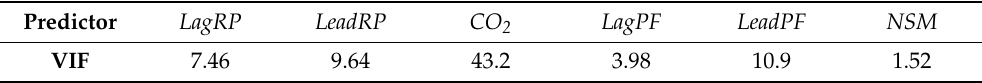
Table 4. Variance inflation factors of the predictors of energy consumption in a steel plant. Predictor LagRP LeadRP CO 2 LagPF LeadPF